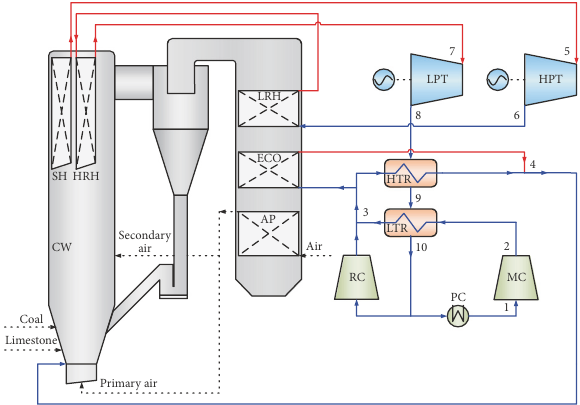
Figure 1: Schematic diagram of recompression S-CO 2 cycle with single reheat.